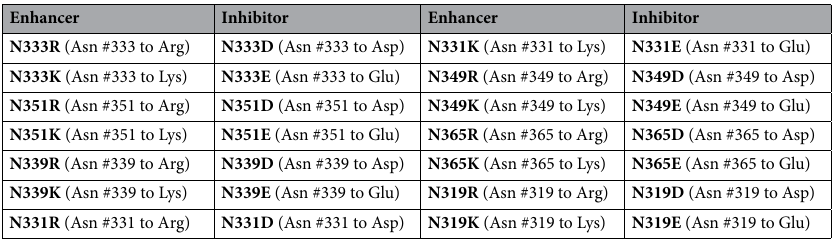
Table 3. Asparagine (Asn/N) amino acid mutants.